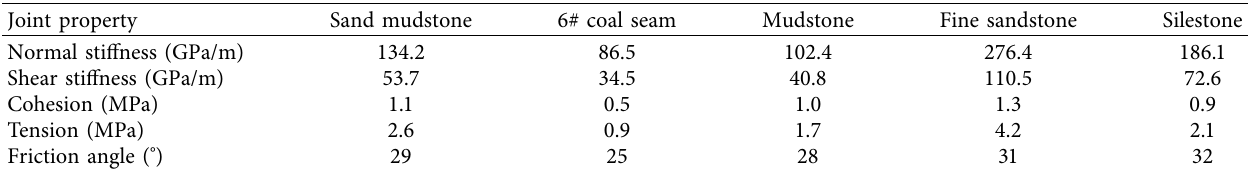
Table 2: Joint mechanical parameters of rock mass.